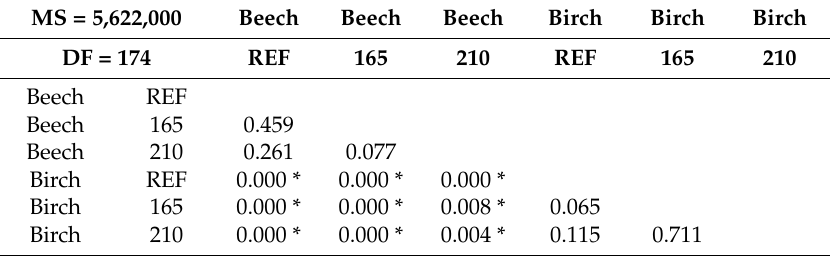
Table A3. Duncan’s Multiple Range Test for Dynamic Modulus of Elasticity.